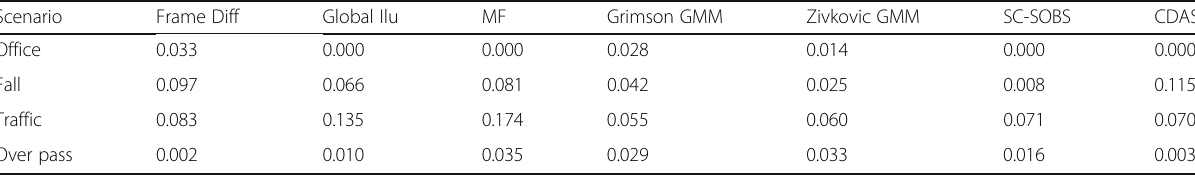
Table 7 Comparisons of FPR of the competing methods over tested scenarios